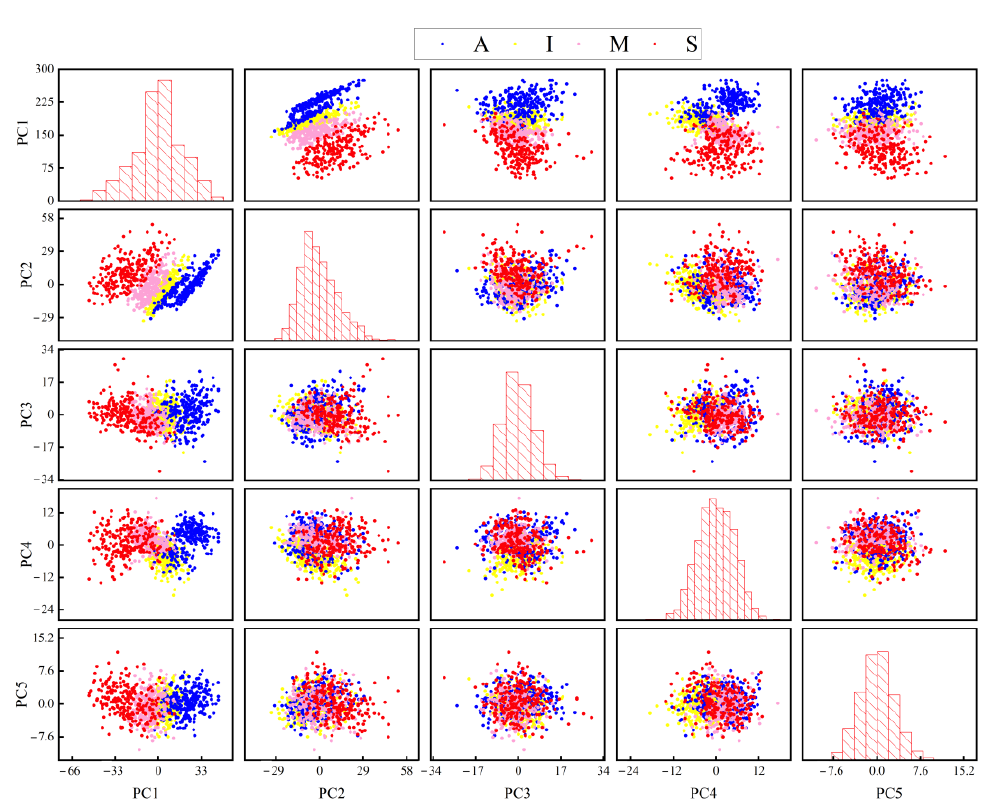
Figure 4. Scatter plot and statistical histogram of combinations between the first five principal components. PC: principal component.